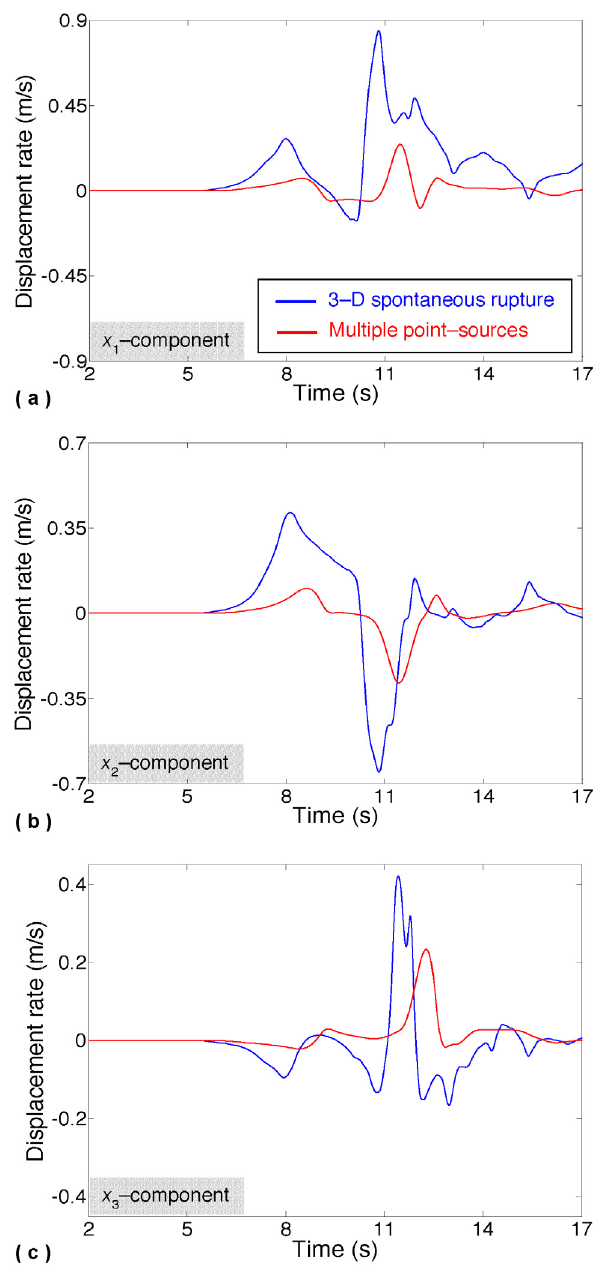
Figure 15. Comparison between the displacement rate at the free surface receiver R, located at a distance of 25 km from the epi- center and 20 km from the fault trace (R is indicated in Figure 14), pertaining to the extended fault model of Figure 11, left column, and to the multiple point-sources. All signal are low-passed at 8